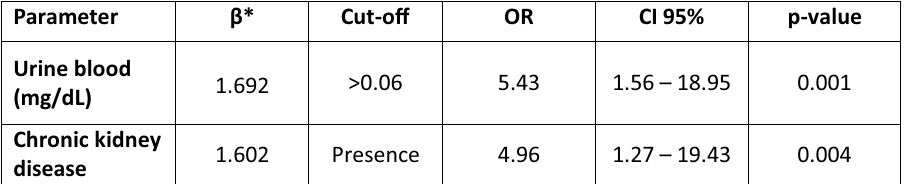
Figure 3. Cut-off values and ROC curve of urine blood and CKD for COVID-19 AKI